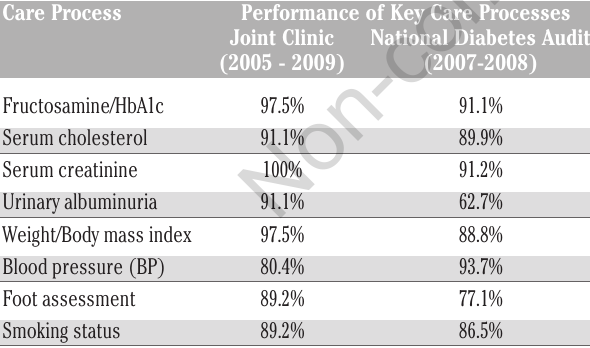
Table 5. Percentage of patients attending Joint Clinic with other